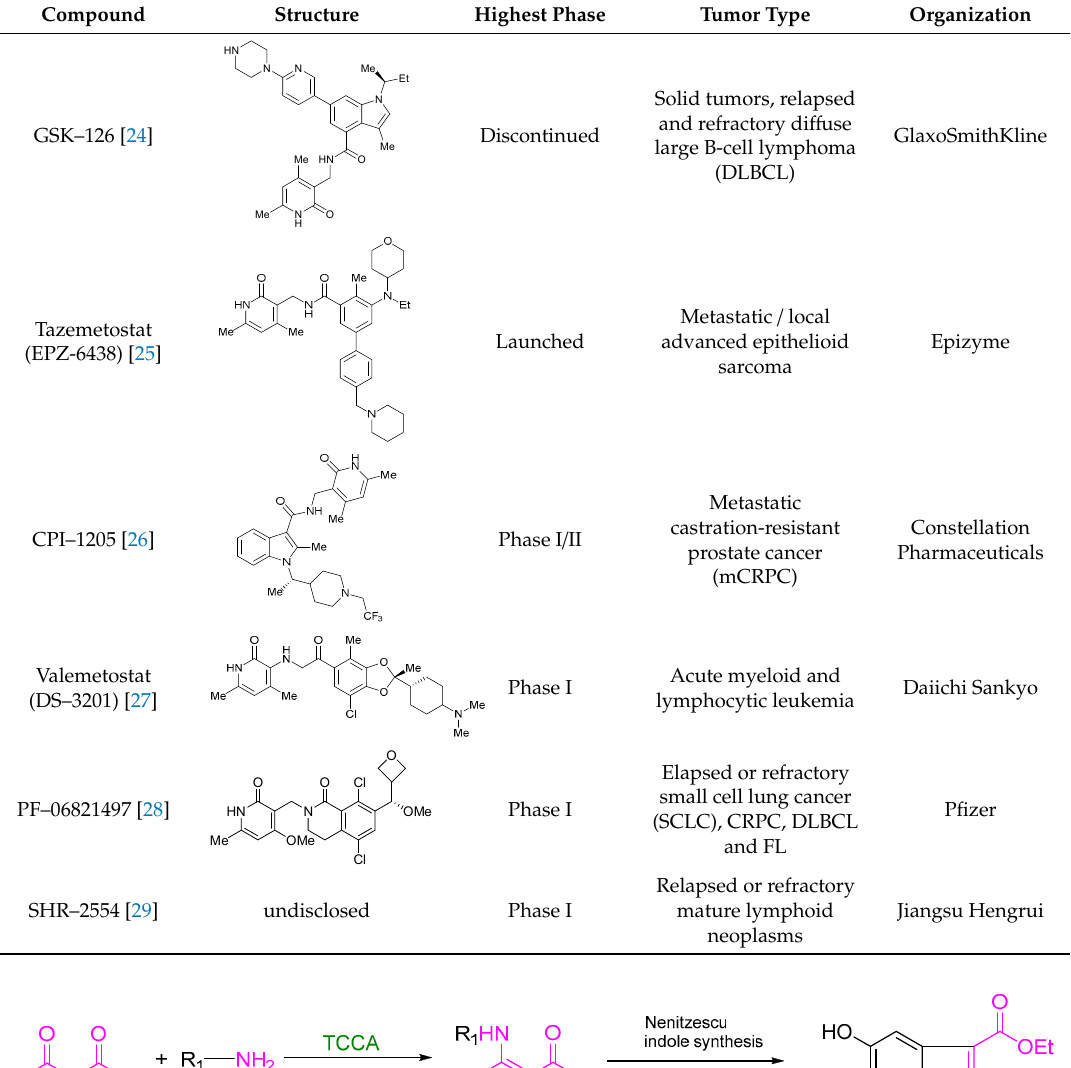
Table 1. Representative EZH2Is in clinical